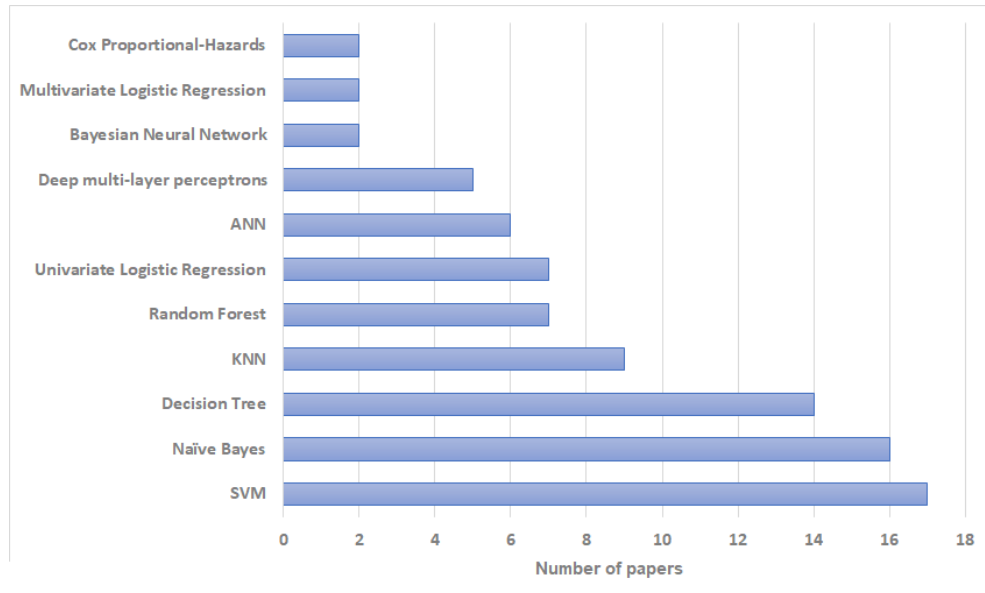
Figure 2. Bar plot showing the frequency of use of different artificial intelligence algorithms in papers included in our review.